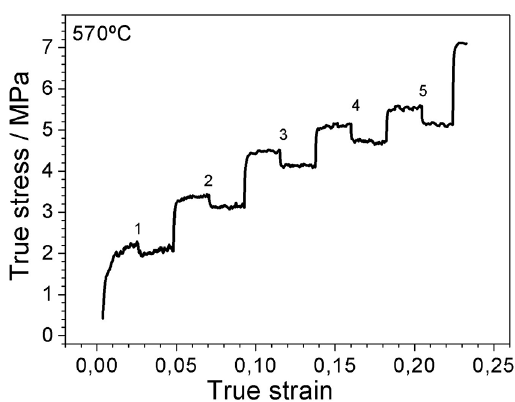
Figure 5. Step test at 570ºC of the coarse-grained AA5083-O, conditions and results about the steps from 1 to 5 are presented on the Table 2.